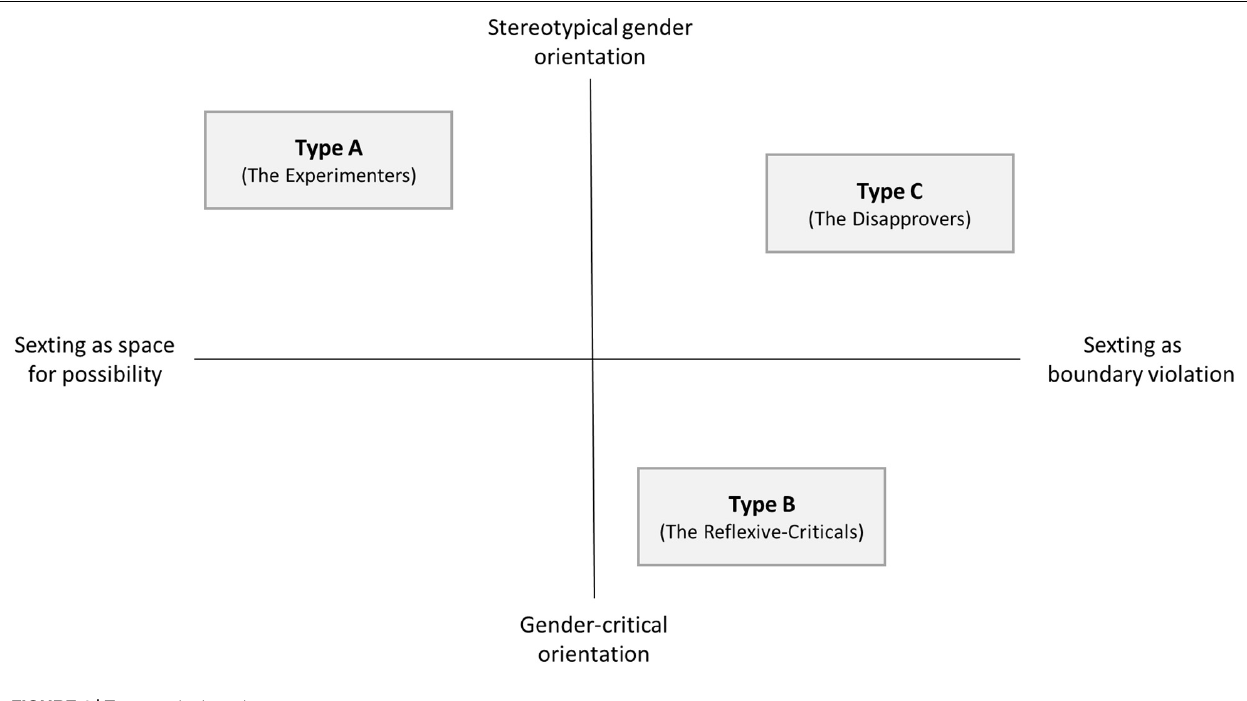
FIGURE 1 | Types and